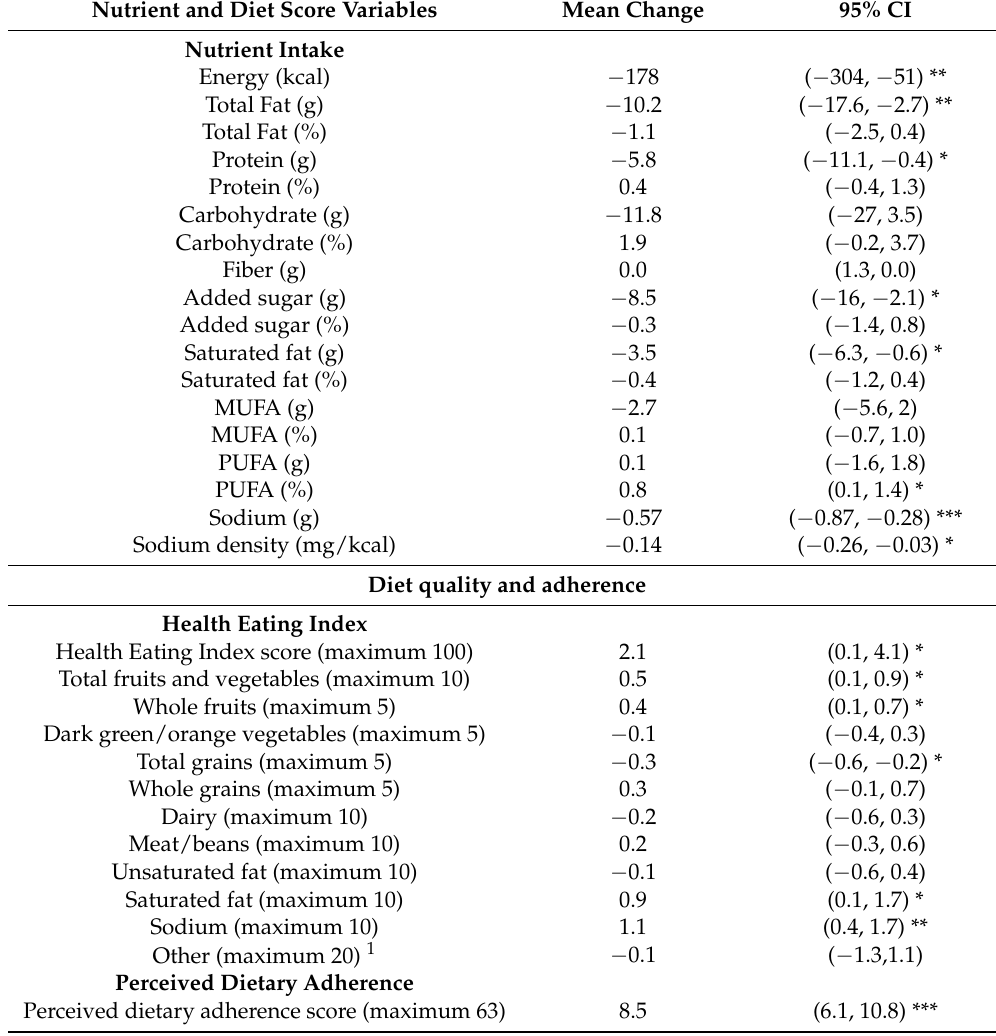
Table 3. Changes in nutrients and food groups, diet quality, perceived dietary adherence at 3 months derived from repeated 24-h